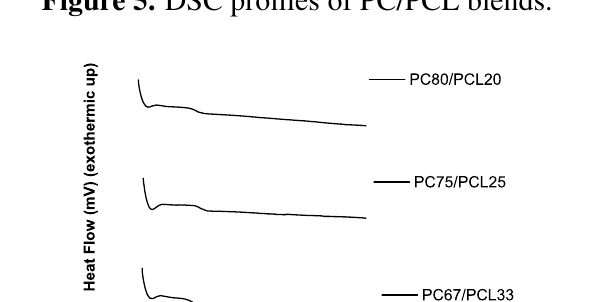
Figure 5. DSC profiles of PC/PCL